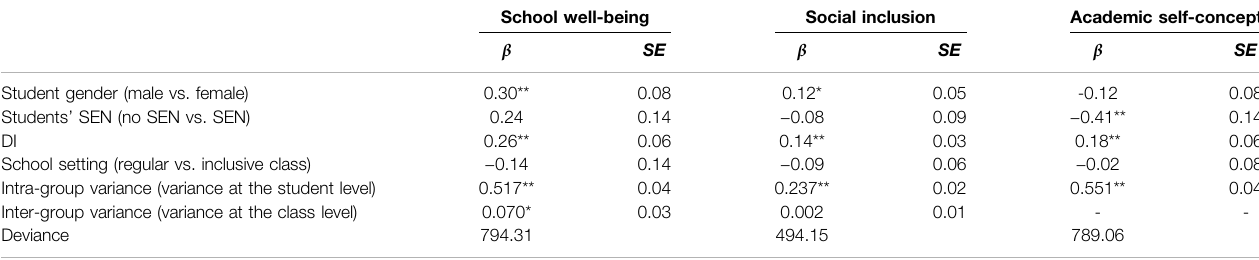
TABLE 4 | Estimates of the multilevel regression analyses to predict attitudes towards school, social integration, and school concept (Model 2 with predictors). School well-being